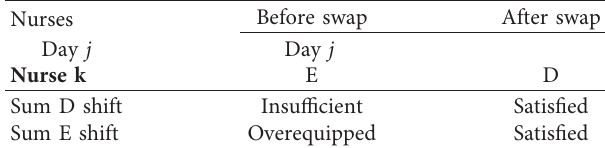
Table 9: An example of VNS2.